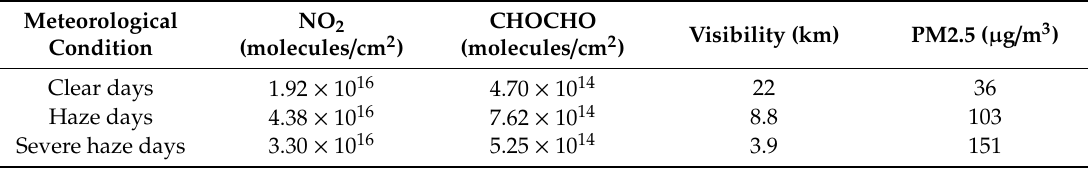
Table 3. Average concentrations of NO 2 , CHOCHO, PM2.5, and visibility under different meteorological conditions.